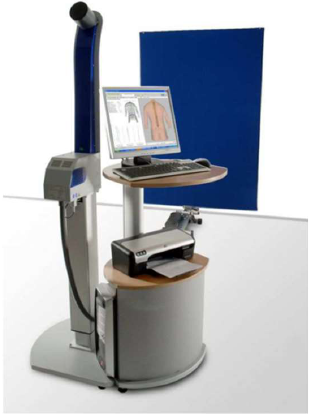
Figure 2. Diers Formetric III